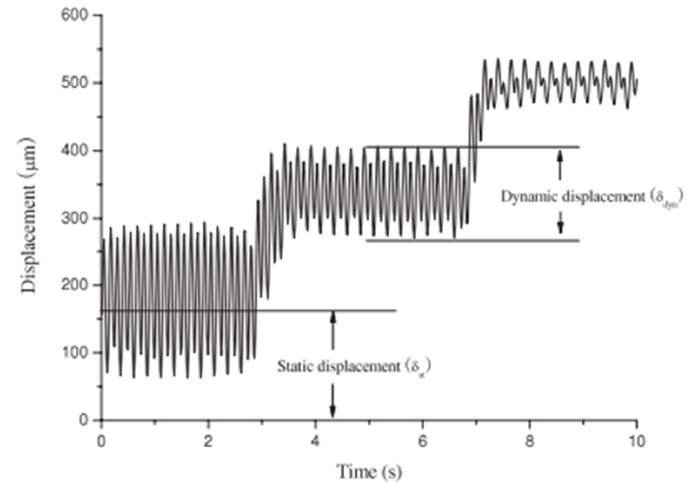
Figure 12. Static and dynamic tip deflection of the force transducer under 350 V mm −1 and 80% relative humidity condition [52].